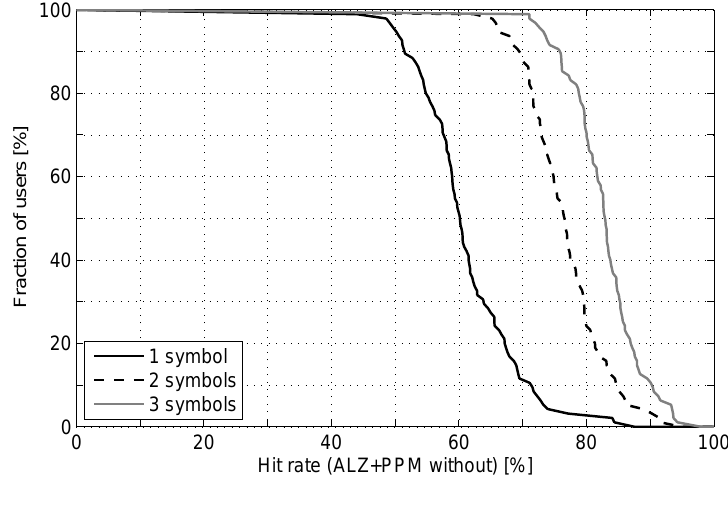
Figure 11. Hit rate attained by Active LeZi+PPM without exclusion when different number of symbols are used as